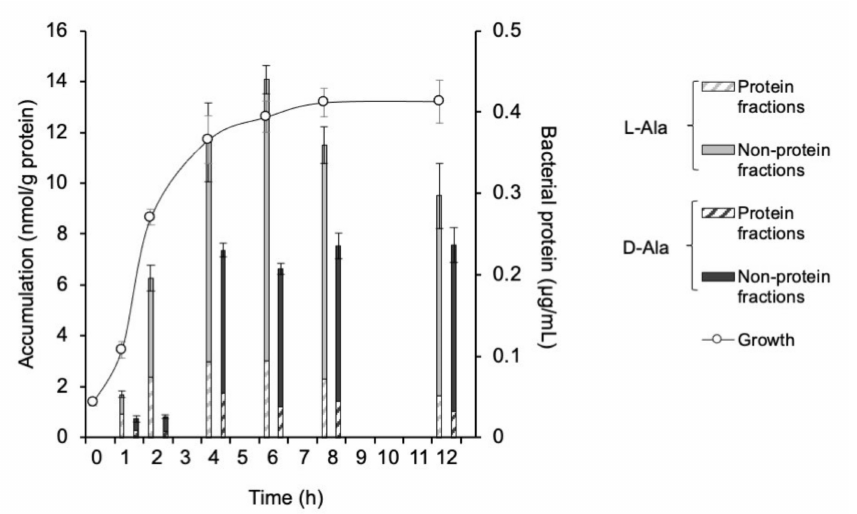
Figure 2. Accumulation of 3 H-L-Ala and 3 H-D-Ala in E. coli EC-14 at 5 min after each injection. EC-14 was incubated in amino-acid-free DMEM for 1, 2, 4, 6, 8, and 12 h. The accumulation of 3 H-L-Ala was greatest at 6 h after incubation, whereas the accumulation of 3 H-D-Ala was greatest after an incubation time of 12 h; however, there was little change in accumulation at 4 h or later after incubation. The incorporation rate of 3 H-L-Ala was higher than that of 3 H-D-Ala at all EC-14 incubation times.